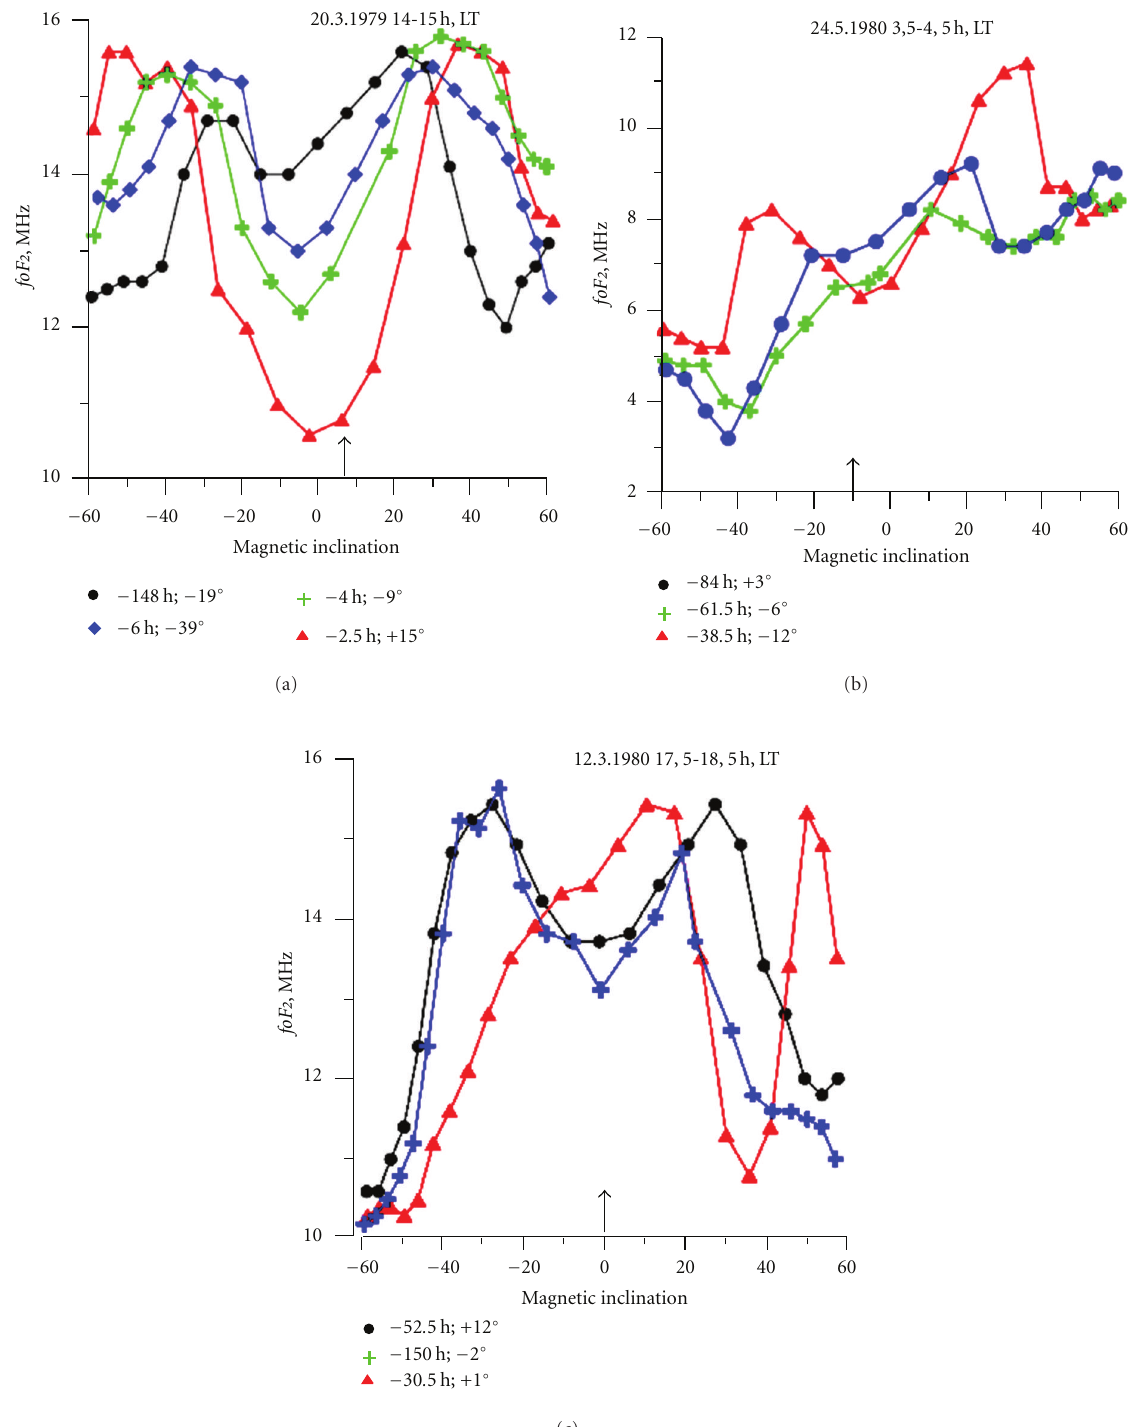
Figure 3: From left to right: deepening of the anomaly trough between crests, formation of crests in predawn hours, and strong distortion of equatorial anomaly with trough movement to the north from geomagnetic equator. Vertical arrows indicate the latitudinal position of the earthquake epicenter. In the figure legends the left column of numbers indicates the time (in hours) of satellite pass over the epicenter latitude in relation to the earthquake moment. Sign − indicates time before the shock and sign + time after the shock. The right column of numbers shows the longitudinal shift of the satellite orbit ground projection in relation to the epicenter